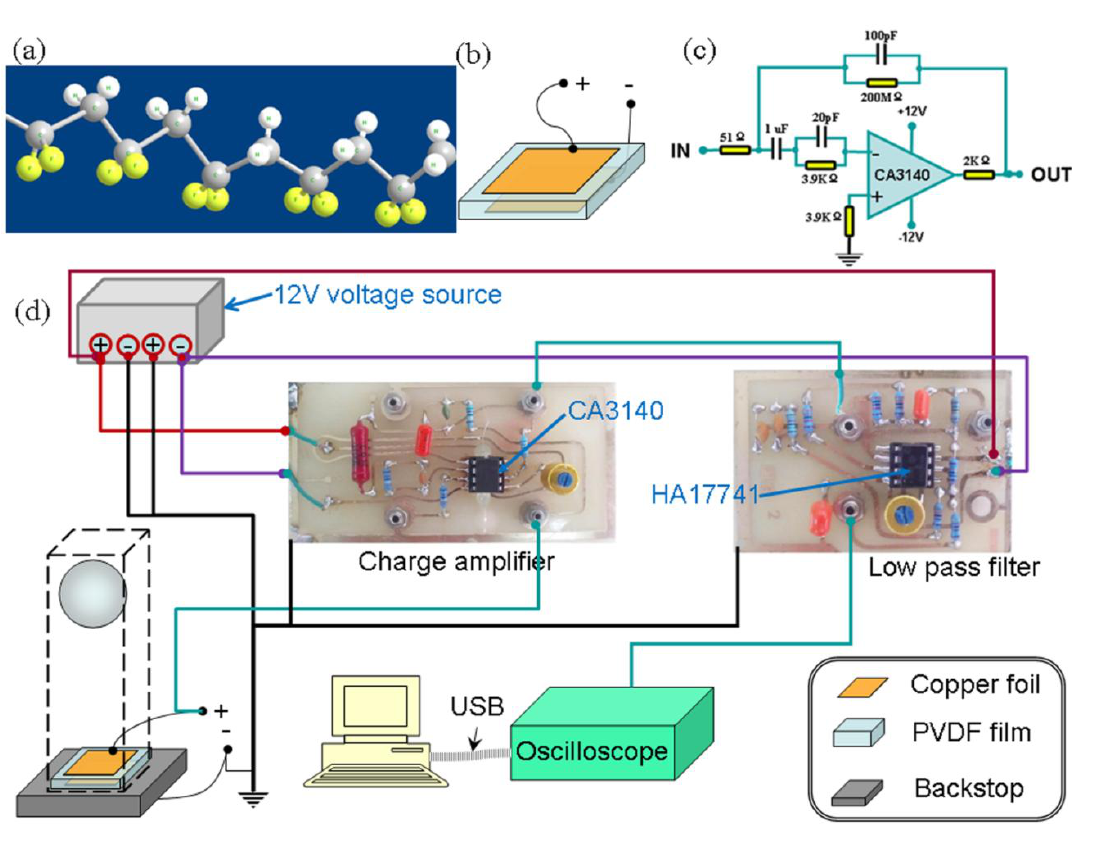
Figure 1. Sketch maps for the PVDF sensor and the related detection system: ( a ) the molecular structure of PVDF; ( b ) the sandwiched structure of PVDF sensor; ( c ) the principle circuit of the charge amplifier used to transform piezoelectric charges generated by PVDF sensor to a voltage signal; ( d ) the outline for the experimental setup and the detection